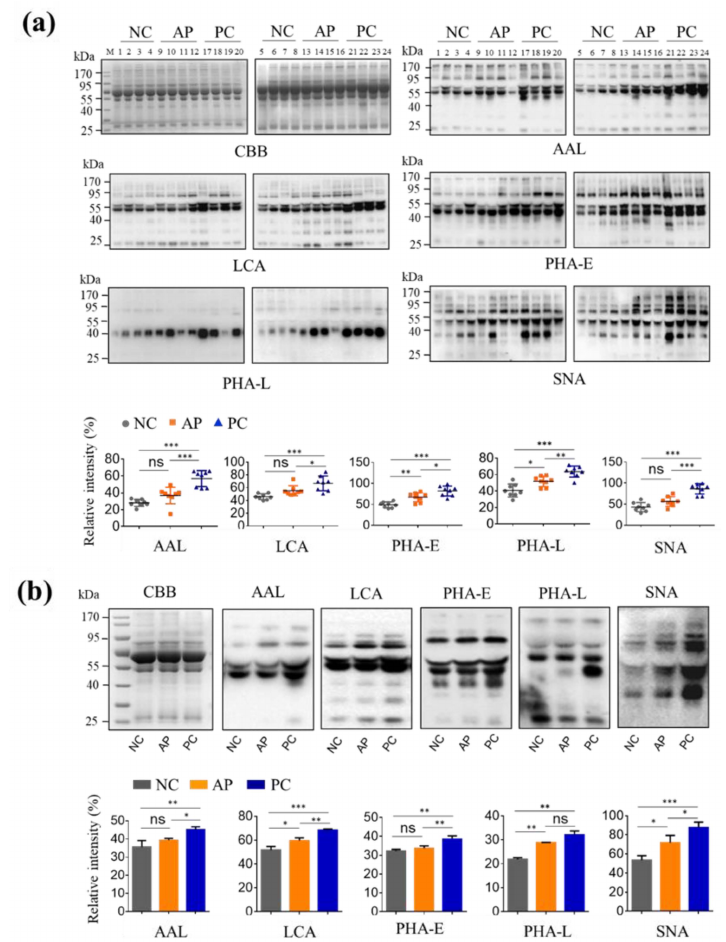
Figure 1. Lectin blotting of PC patients’ serum glycoproteins. ( a ) A total of 5 µ g of serum proteins from NC individuals (1–8), AP (9–16), and PC (17–24) patients were subjected to 10% SDS-PAGE, stained with Coomassie brilliant blue (CBB), or electroblotted membranes to stain with AAL, LCA, PHA-E, PHA-L, and SNA lectins. ( b ) A total of 5 µ g of proteins of pooled sera from NC ( n = 8), AP ( n = 8), and PC ( n = 8) groups were subjected to 10% SDS-PAGE and stained with CBB, and other electroblotted membranes were stained with above lectins. NC, normal control; AP, acute pancreatitis; PC, pancreatic cancer. AAL binds to α 1-2/3/4/6-linked fucose residues. LCA binds to α 1-6-linked fucose residue. PHA-E binds to bisecting GlcNAc N -glycans. PHA-L binds to β 1,6 GlcNAc-branched N -glycans. SNA binds to α 2-6-linked sialic acid residues. The relative intensities of the lectin staining were analyzed using ImageJ, normalized with total protein signal in CBB staining, and finally statistically analyzed by Graphpad Prism 6.0. All values are means ± SD (error bars) from 8 individuals of one group ( a ), or from three independent experiments ( b ) *, significantly different p < 0.05; **, p < 0.01; ***, p < 0.001; ns, no significant